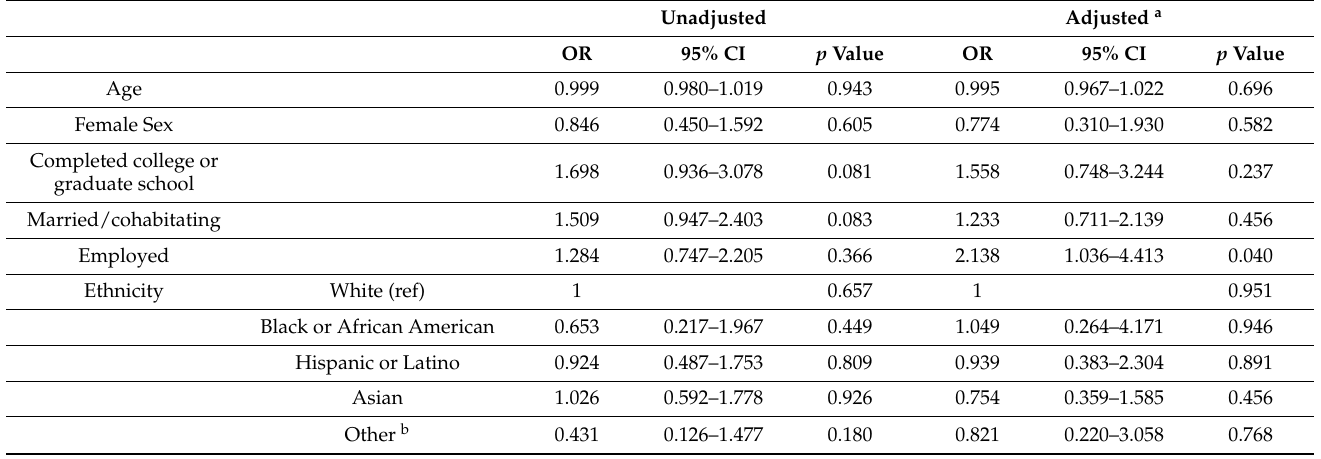
Table 3. Predicting the accuracy of body mass index (BMI) (kg/m 2 ) based on self-reported weight and